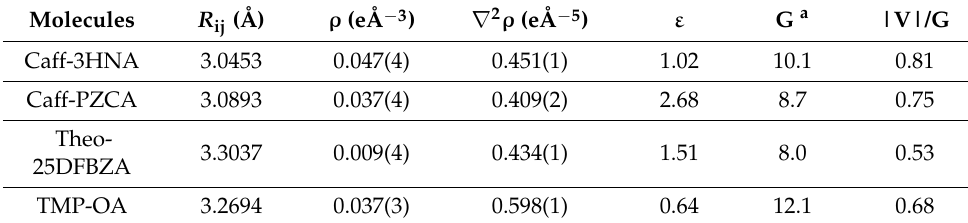
Figure 16. Bond paths (golden curved segments) along with critical points of hydrophobic Me∙∙∙Me interactions derived from experimental CDMM. (3,−1) BCPs, (3,+1) ring critical point (RCP), and (3,+3) cage critical points (CCP) are represented by the violet, orange, and green spheres. Reprinted with permission from reference. [78] Copyright 2019, American Chemical Society. Table 5. Experimental topological values of Me ··· Me HIs at (3, − 1) bond critical points. Table 5. Experimental topological values of Me∙∙∙Me HIs at (3,−1) bond critical points. Molecules